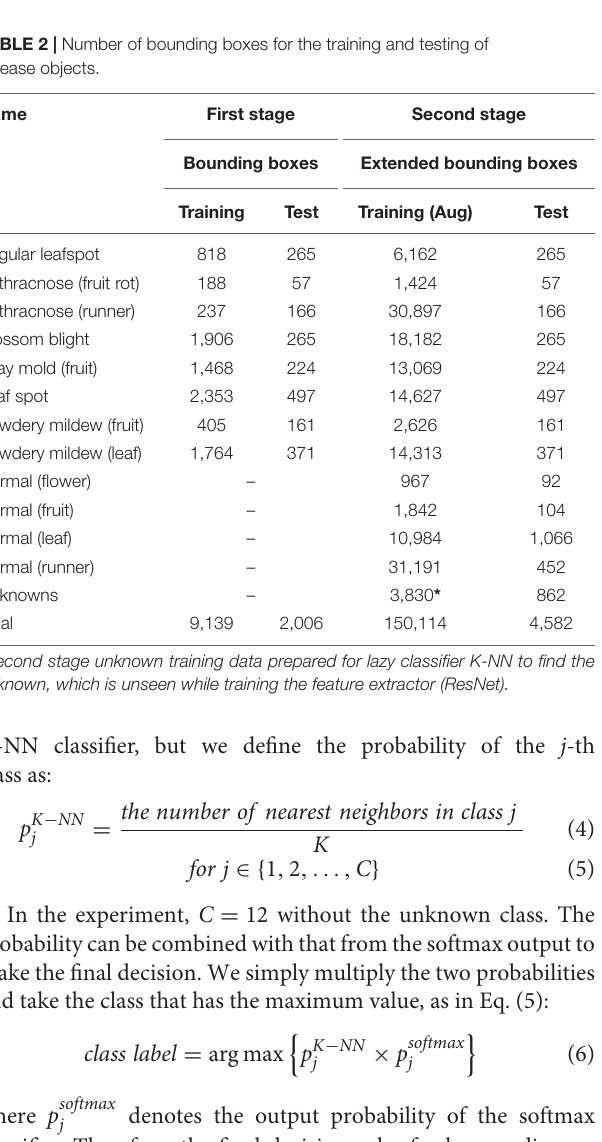
FIGURE 4 | K -nearest neighbor ( K -NN) classifier to categorize the disease classes with unknowns.